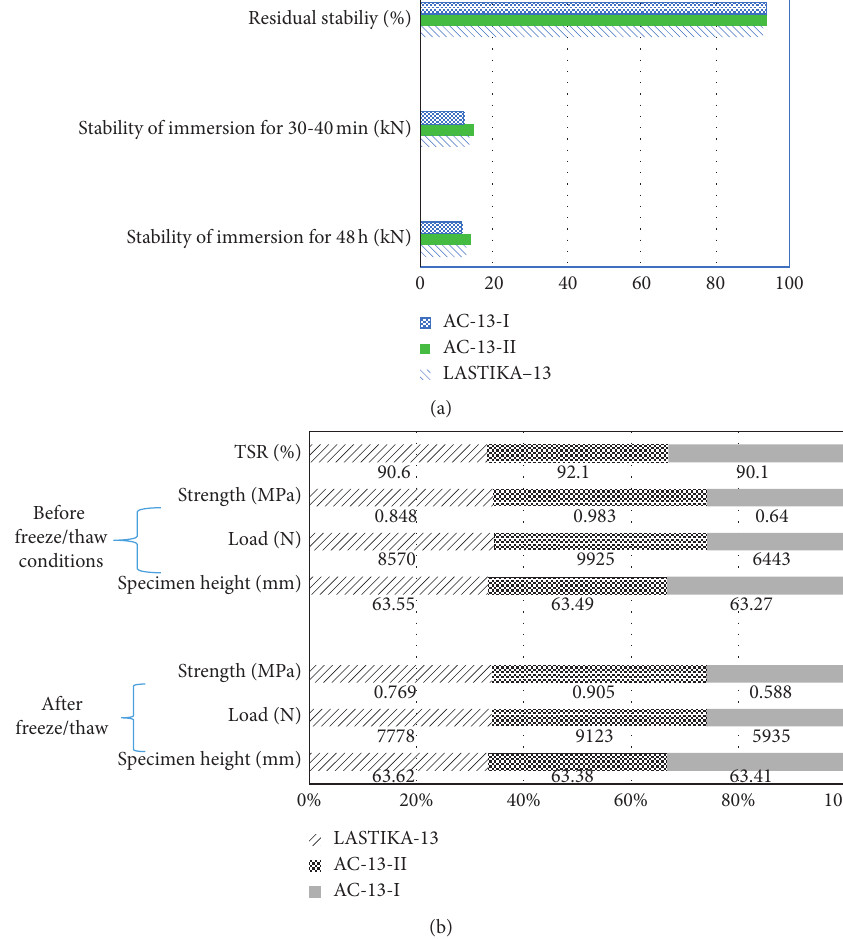
Figure 9: Tensile Strength Ratio (TSR) results of asphalt mixtures: (a) Marshall stability test results of asphalt mixtures. (b) Sample dimensions and loading conditions of asphalt